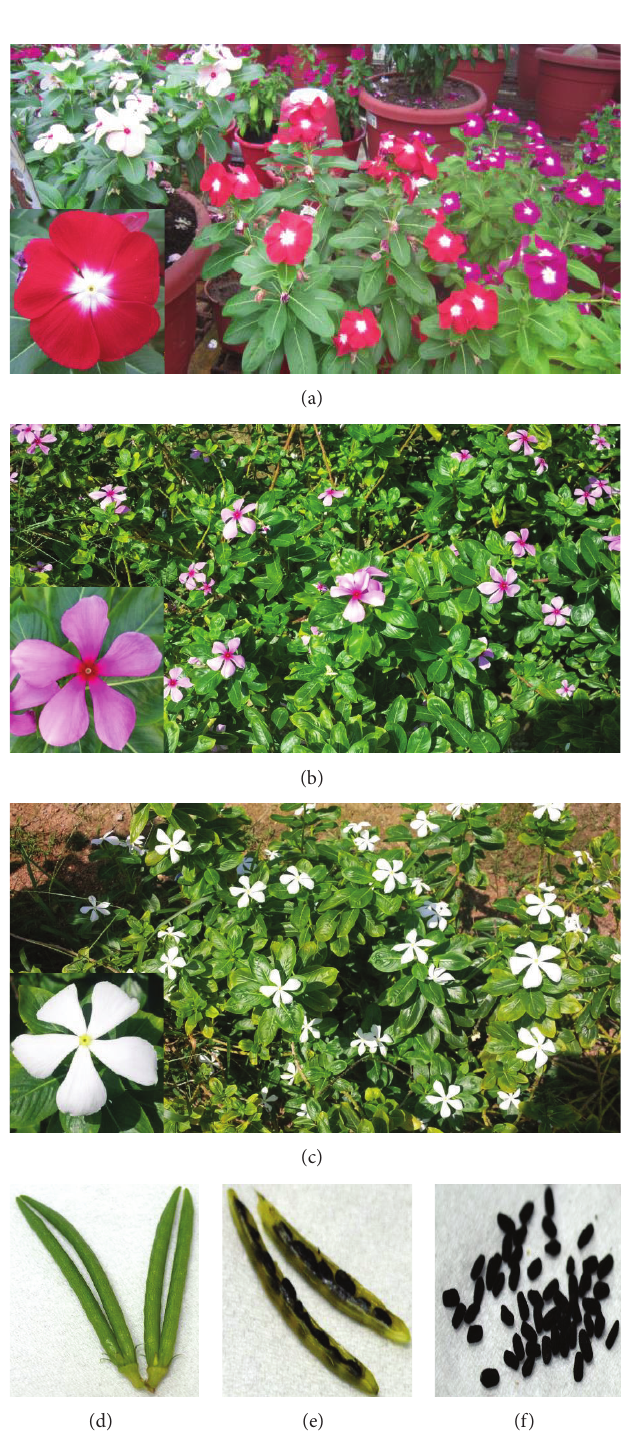
Figure 1: (a) Artificial hybrids of MP in flower stage; (b) wild types with purple flowers “rosea”; (c) wild types with white flowers “alba”; (d) fruits which are composed of two free narrow cylindrical follicles; (e) seeds inside the follicle; (f) seeds. All images represent the real sizes, approximately. The artificial hybrids are clearly differentiated from those wild types due to their floral architecture and petals structure which are wider, thicker, and more compressed than the wild